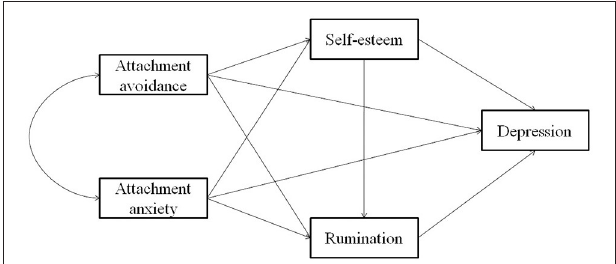
FIGURE 1 | Hypothesis model of the current